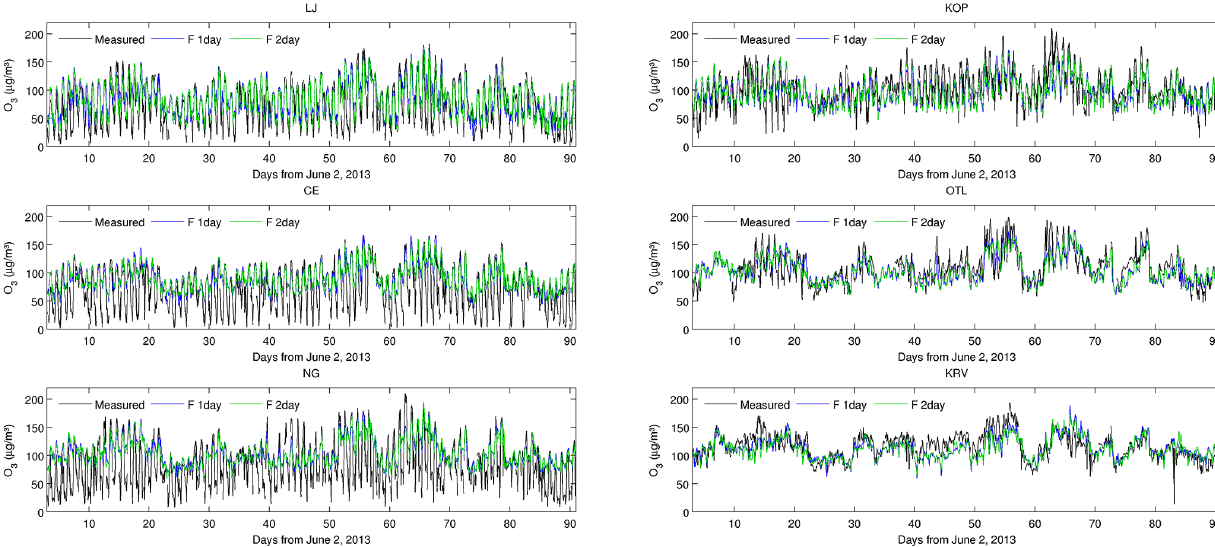
Figure 5. Time evolution of hourly ozone concentrations for 1-day (F 1 day) and 2-day (F 2 day) WRF-Chem predictions and measurements for some stations during the 3-month